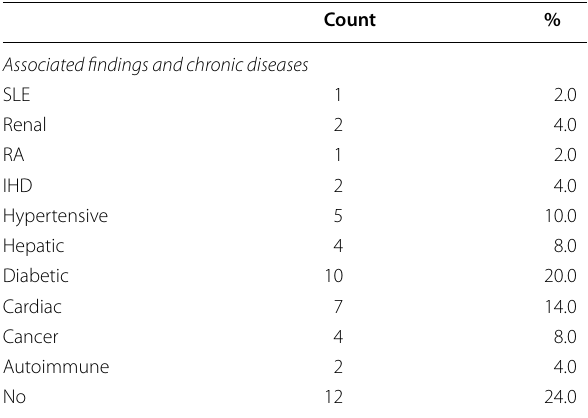
Table 1 The count and percentage of the associated chronic